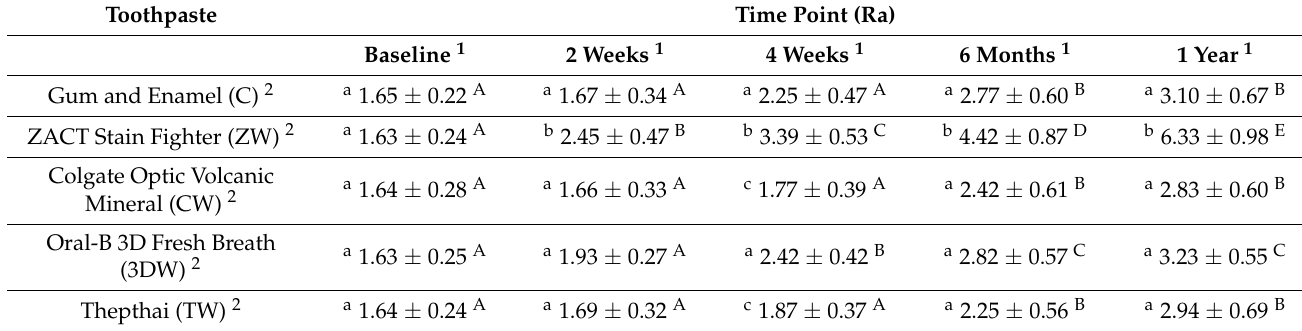
Figure 2. ( a ) Average roughness after brushing at each time point analysed using one-way ANOVA and LSD post hoc test. Different lowercase letters indicate statistically significant differences among toothpaste groups ( p < 0.05). ( b ) Average roughness after brushing among time points was analysed using Friedman test with Dunn’s post hoc test. Different superscript capital letters indicate statistically significant differences only among the evaluation periods in the same groups ( p < 0.05). Table 3. Mean and standard deviation of roughness (Ra) after brushing. In the same column, different superscript lowercase letters indicate statistically significant differences among toothpaste groups. In the same line, different superscript capital letters indicate statistically significant differences only among the evaluation periods in the same groups ( p <